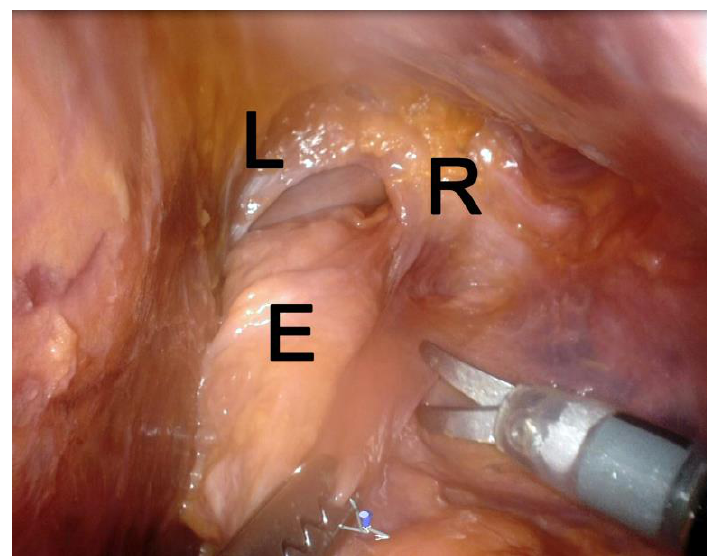
Figure 6. Da Vinci SP transcervical view on the hiatus; (L) left crus; (R) right crus; (E) esophagus.